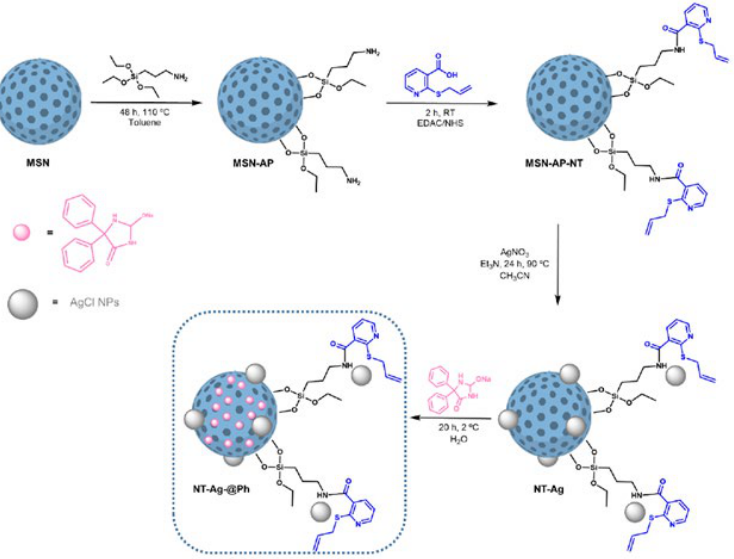
Figure 13. Synthesis scheme of mesoporous silica nanoparticles (blue sphere) loaded with a dual system of a nicotinic acid (pink spheres) and silver chloride NPs (grey spheres) [120]. Reproduced with permission. Copyright © Authors of the publication (open access).